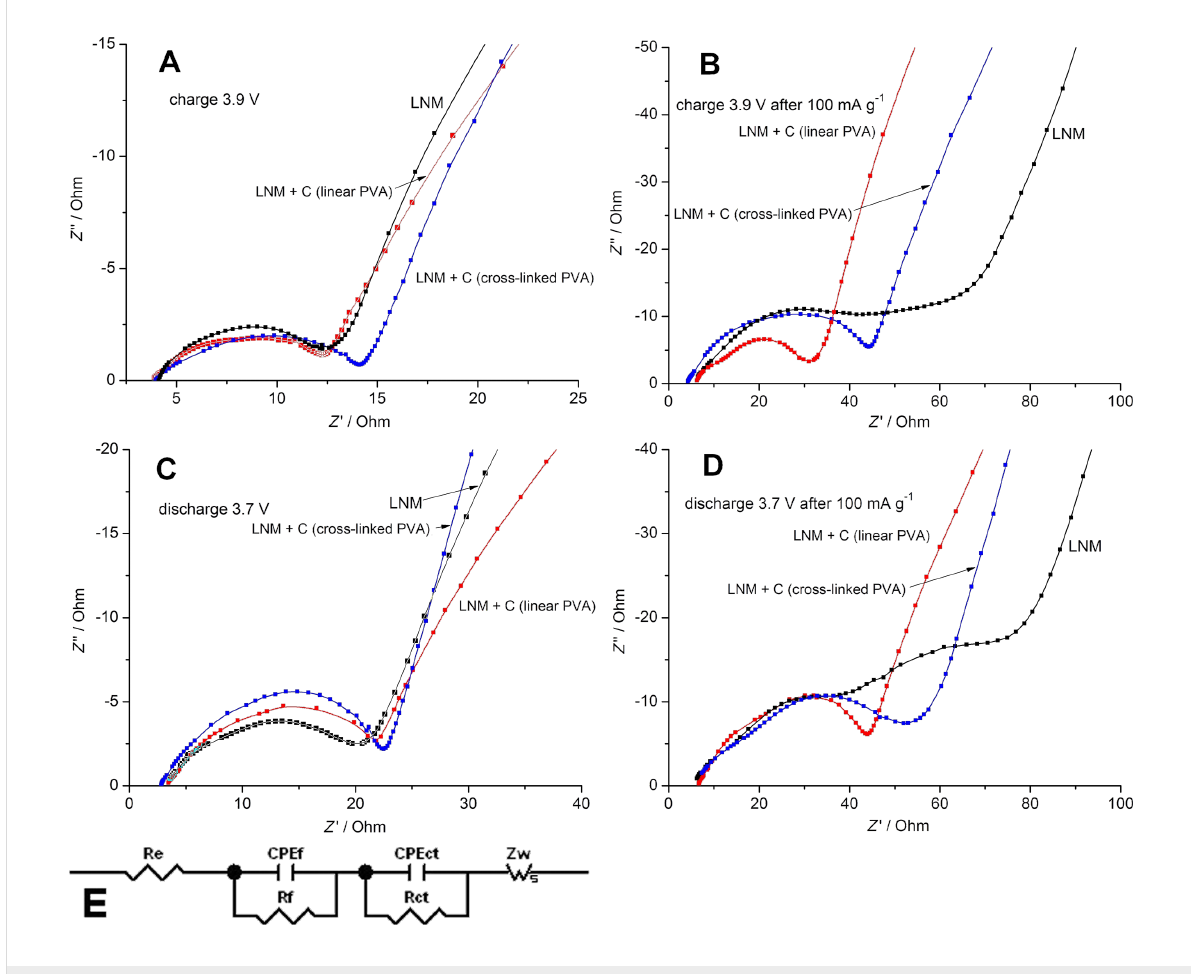
Figure 5: Nyquist plots of pure Li 1.4 Ni 0.5 Mn 0.5 O 2+ x and LNM/C nanocomposites at the charge potential of 3.9 V: A) 1st cycle, B) after cycling at dis- charge currents of 20–100 mA·g − 1 (15th cycle); at the discharge potential of 3.7 V: С ) 1st cycle, D) after cycling at discharge currents of 20–100 mA·g − 1 (15th cycle). E) Equivalent circuit used for fitting the EI spectra.